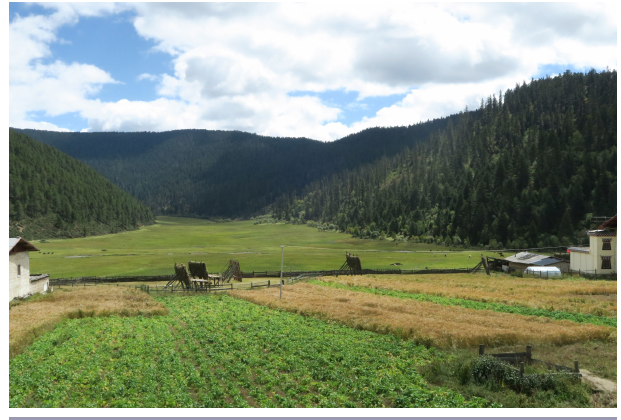
Fig. 2 . Villagers live in the park practicing agropastoralism for local livelihood and cultural needs, and also have aesthetic value for